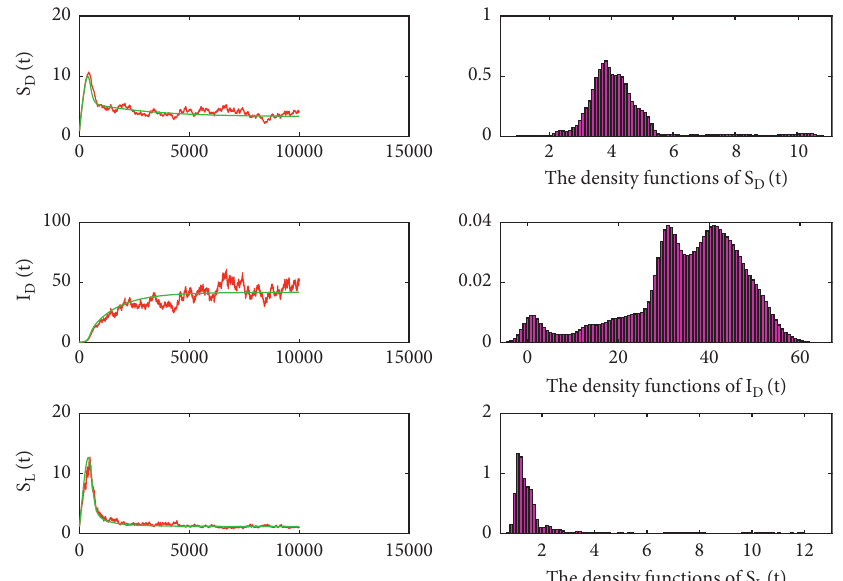
Figure 1: The red lines describe the solution of system (2); the green lines stand for the solution of the corresponding system (1). The right pictures are the histogram of the density function for S D , I D , and S L